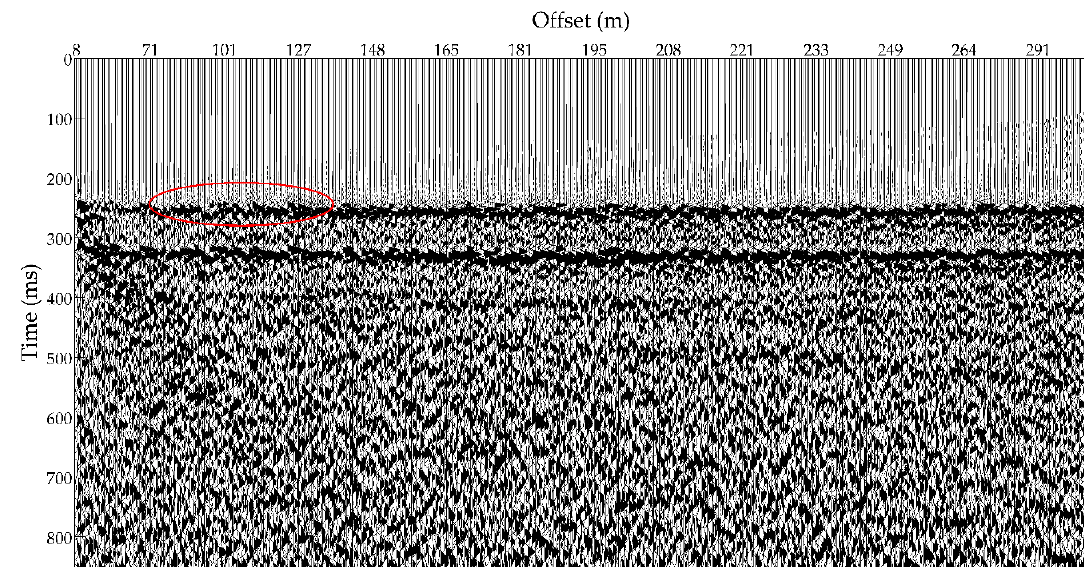
Figure 4. Shot gather (No. 624) after linear move-out (LMO).